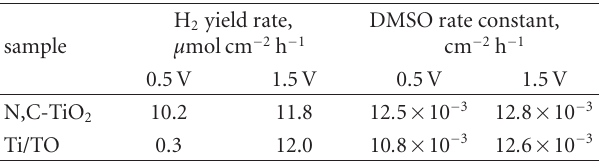
Table 2: Hydrogen yield rates and degradation rate constants of the Ti/TO and N,C-TiO 2 electrodes under illumination of AM 1.0 stimulated solar